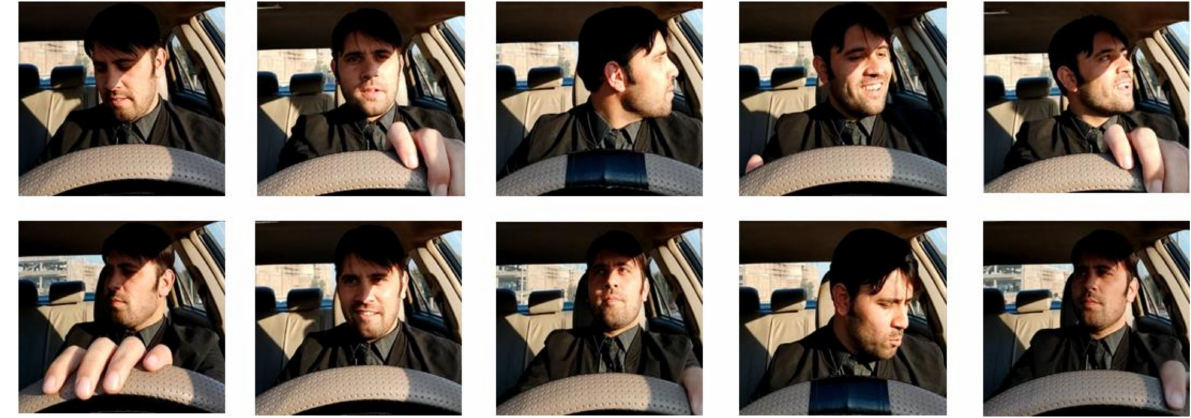
Figure 4. Random gazes recorded for the developing benchmark